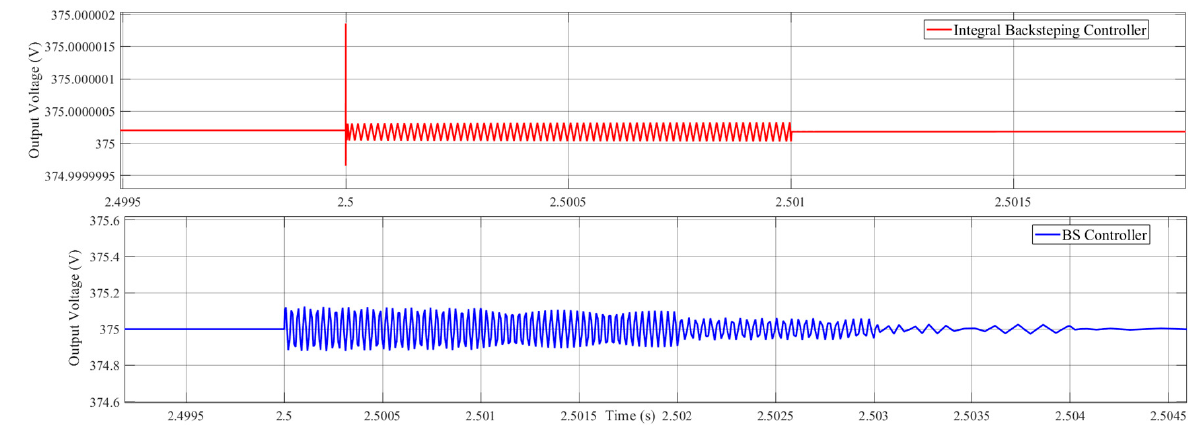
Figure 28. Comparison of NLIBC and backstepping (BS) for voltage regulation zoomed in view. Figure 29 represents the system frequency comparison of NLIBC and BS controller